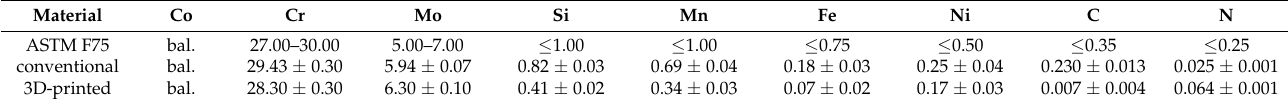
Table 1. Chemical composition (wt%) of the studied Co-28Cr-6Mo